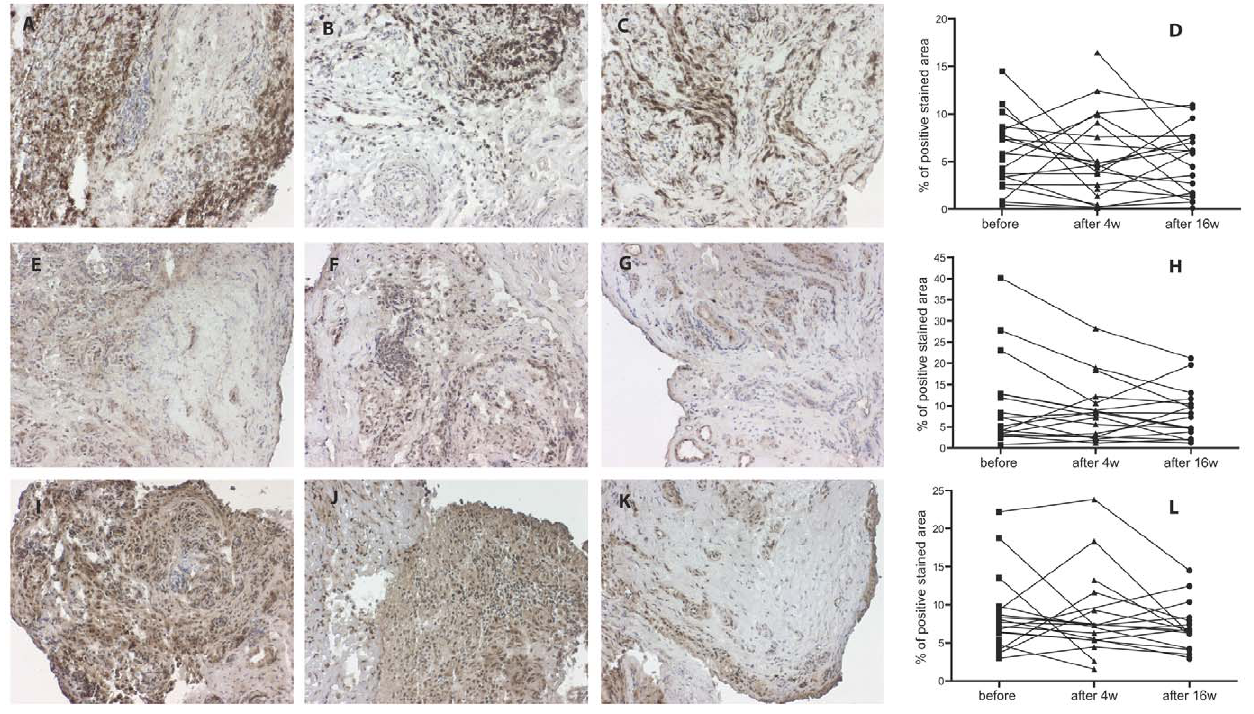
Figure 3. Minimal influence of rituximab treatment on expression of MPGES1, COX-1 and COX-2 in synovial tissue. Immunohistochemical staining of frozen biopsy sections from rheumatoid arthritis patients shows diaminobenzidine staining (brown) of MPGES1 (A–C), COX-2 (E-G) and COX-1 (I–K) before treatment, 4 weeks and 16 weeks after treatment (hematoxiline counterstained). Graphs depict image analysis of MPGES1 (D), COX-2 (H) and COX-1 (L) expression in stained sections from patients’ biopsies at the different time points. Original magnification 150x.